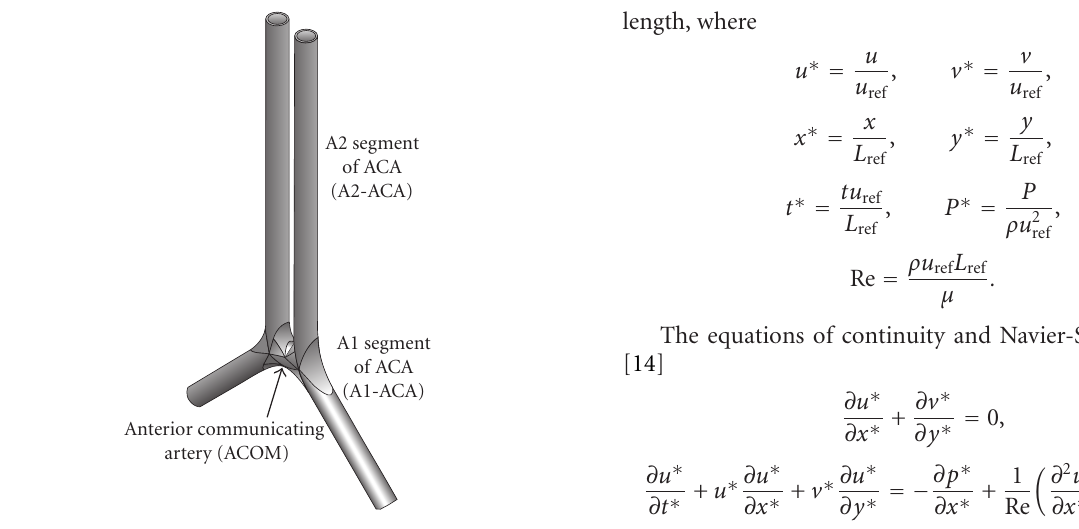
Figure 1: A 3D model depiction of the anterior cerebral circulation upon which the simulation is